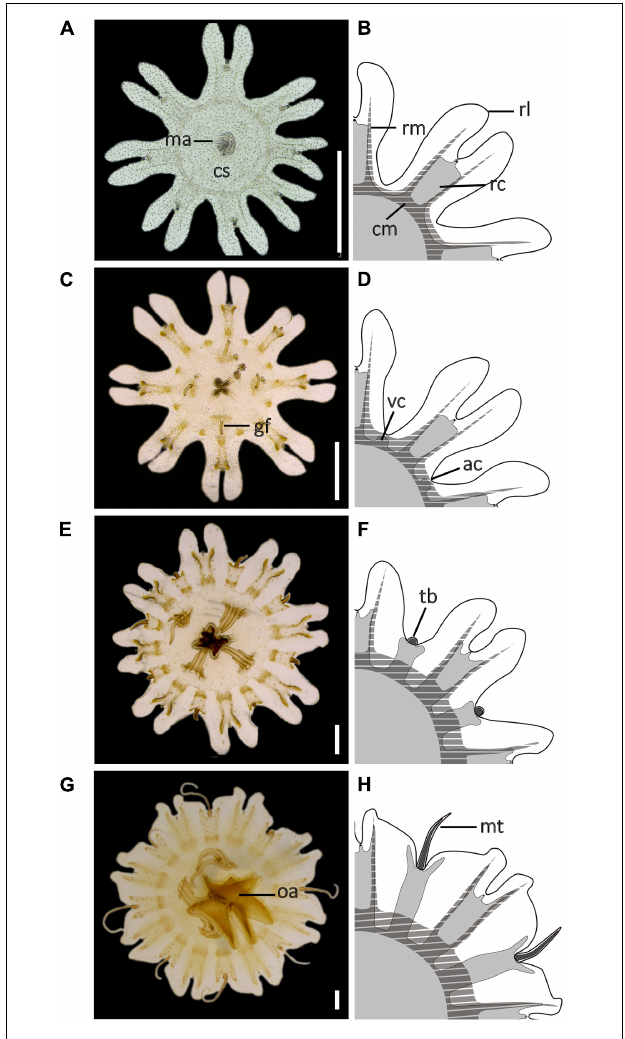
FIGURE 3 | Development of the early stages during the life cycle of Pelagia noctiluca . (A,B) Ephyra, stage 1. (C,D) Ephyra, stage 2. Note the difference in the presence of gastric filaments and velar canals. (E,F) Metaephyra, stage 3. (G,H) Metaephyra, stage 4. (A,C,E,G) Ephyra and metaephyra, ventral view. (B,D,F,H) Ephyra and metaephyra, body quadrant illustrations. White, subumbrella; light gray , gastric system without marginal tentacles; dark gray, gastric canals inside marginal tentacles; striped, muscular system. ac , adradial cleft; cm , circular muscle; cs , central stomach; gf , gastric filament; ma , manubrium; mt, marginal tentacle; rc, rhopalial canal; rl, rhopalial lappet; rm , radial muscle; oa , oral arm; tb, tentacle buds; vc, velar canal. Scale bars: 1 mm. Illustrated by Lau